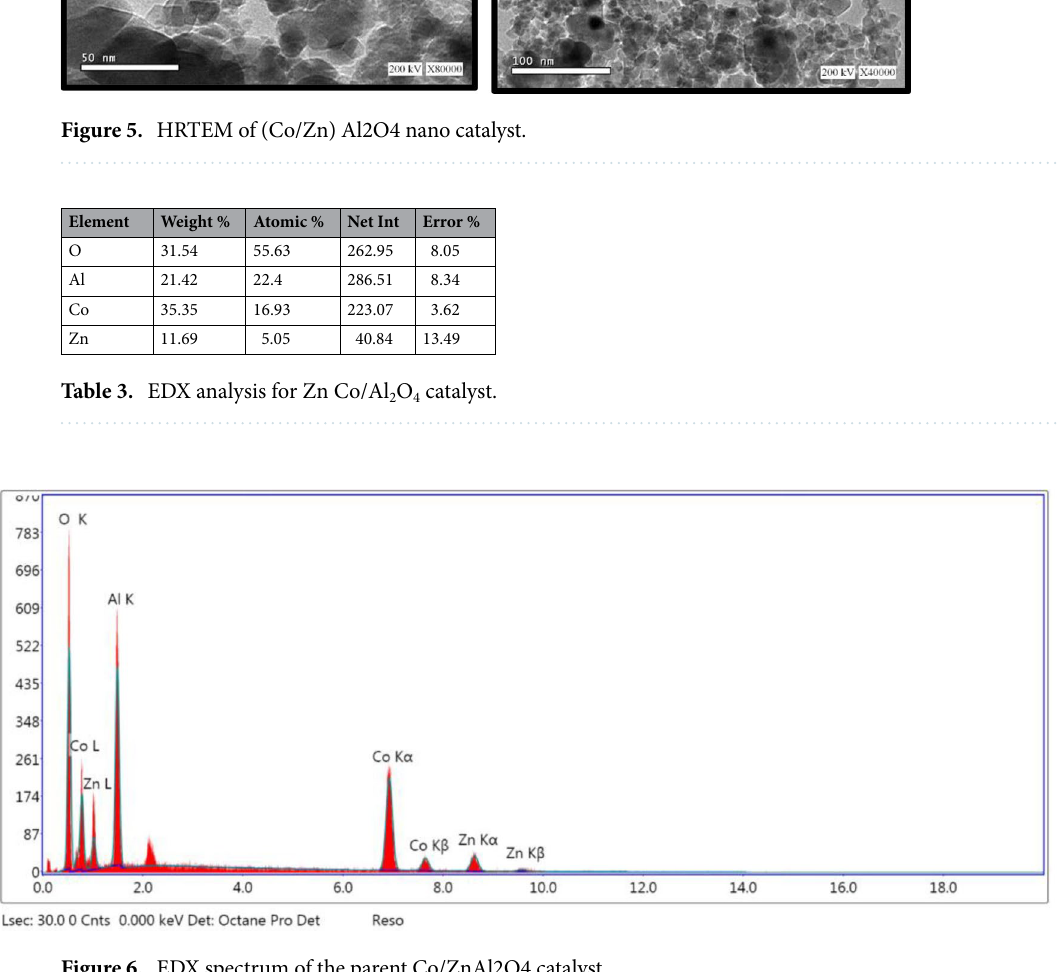
Figure 6. EDX spectrum of the parent Co/ZnAl2O4